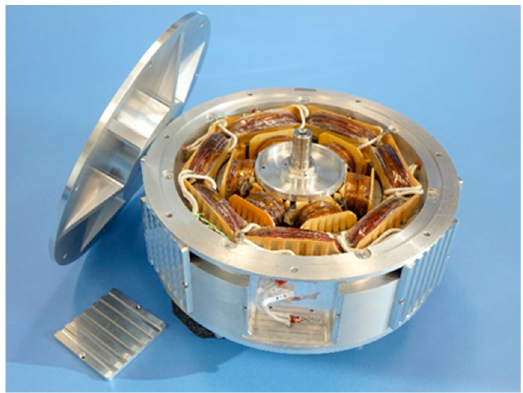
Figure 11. Machine prototype of WRSM with 7 phases, 7 slots, and 6 poles.